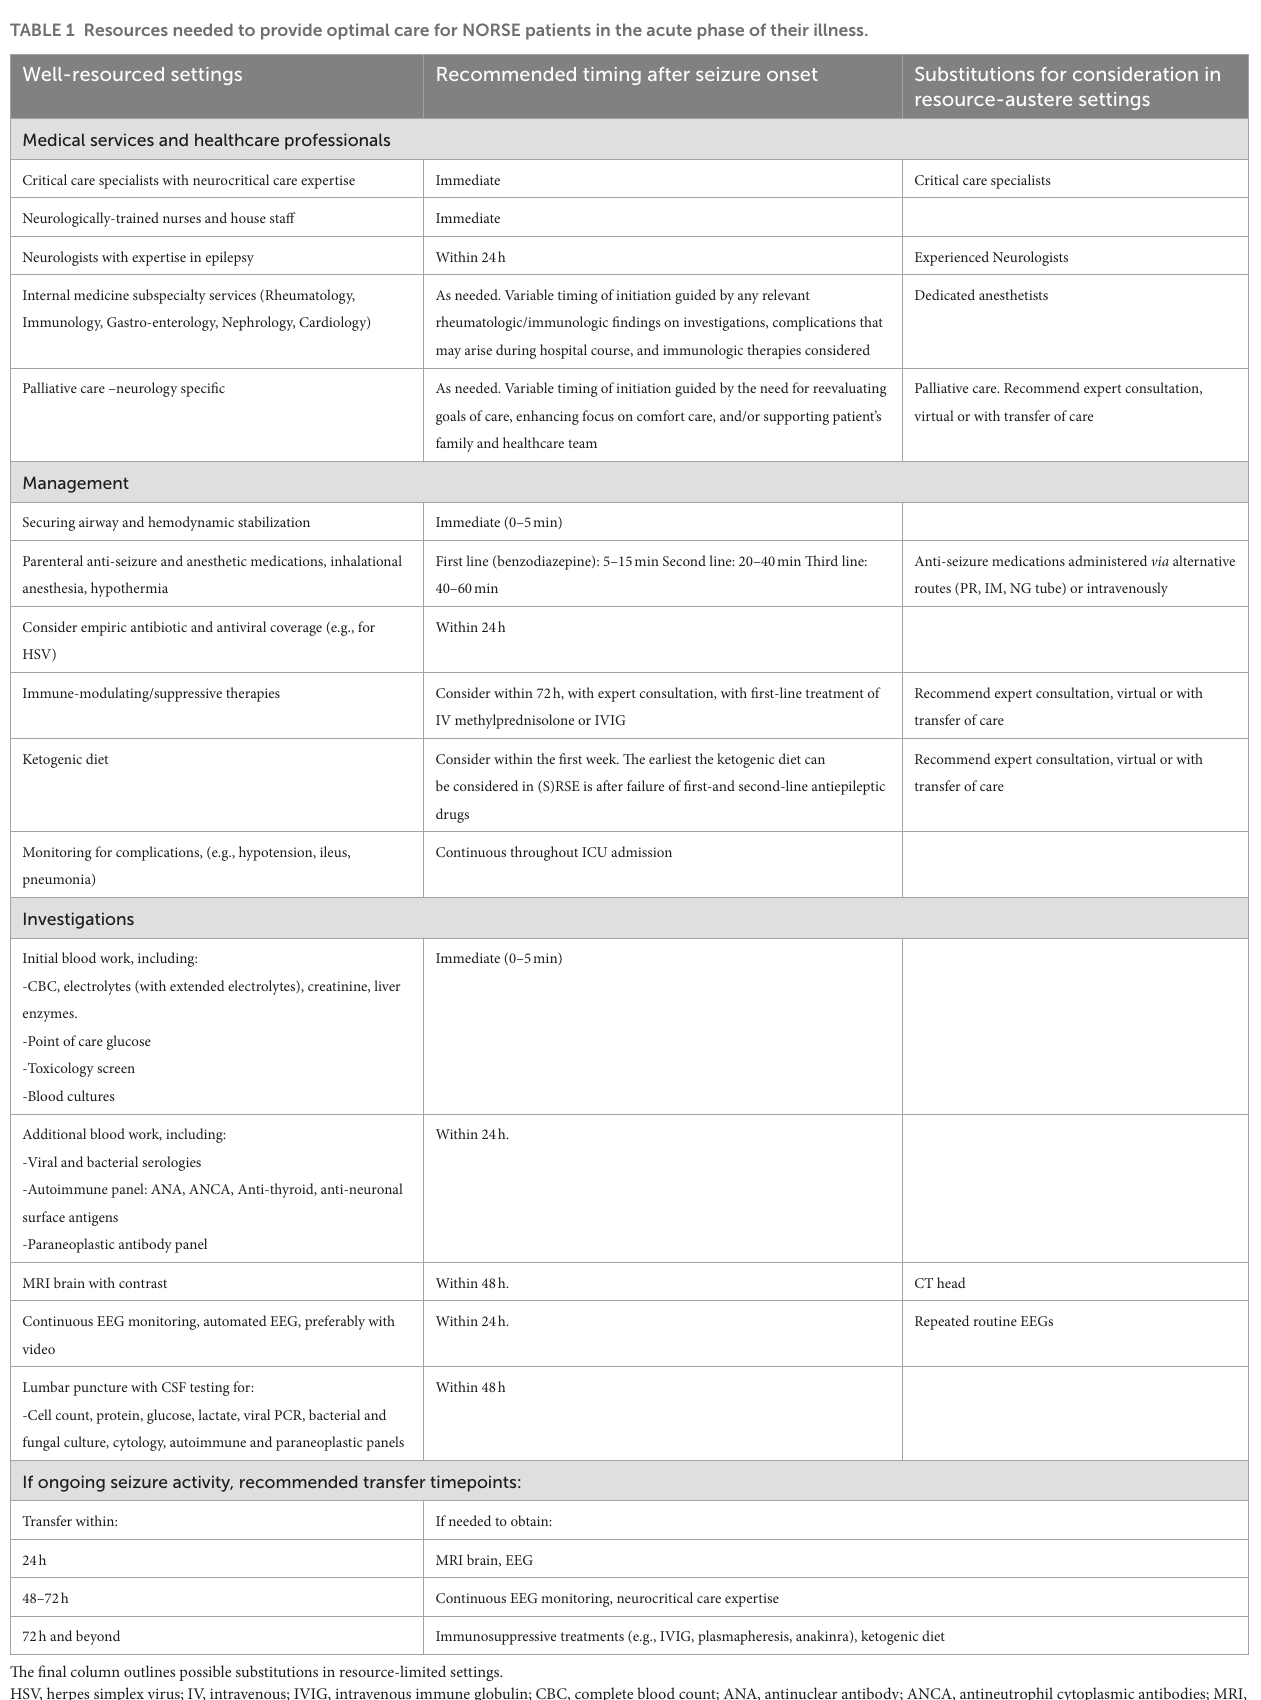
TABLE 1 Resources needed to provide optimal care for NORSE patients in the acute phase of their illness. Well-resourced settings Substitutions for consideration in